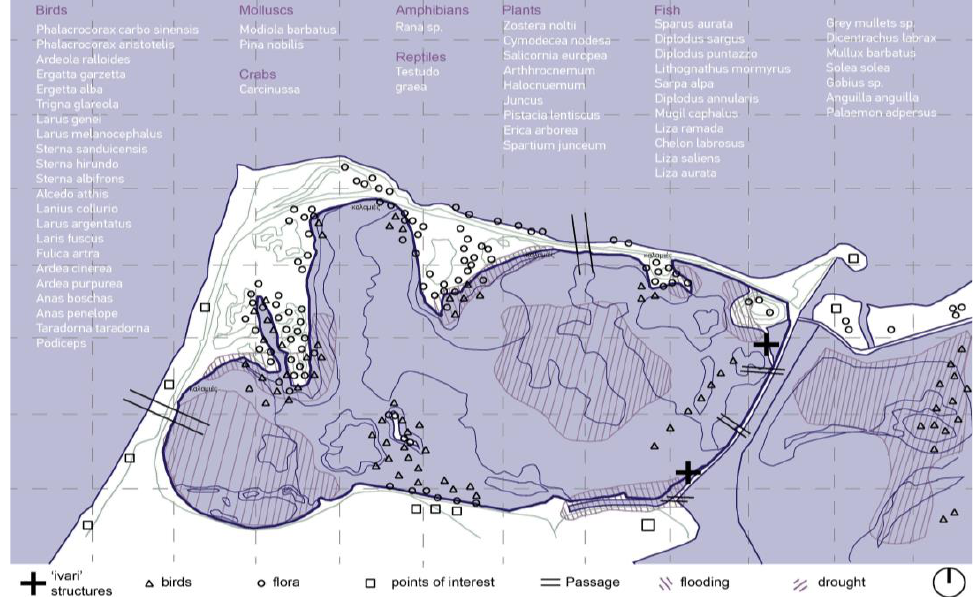
Figure 13. Eleni Kanellopoulou with Karolos Galanos (supervisor), 2022, Urban Safari 38.83, 20.70, Department of Architecture, University of Ioannina. Biodiversity map of the greater lagoon lake area showing species’ variety in relation to the sea tide during the year, which changes due to drought and rainfall periods. Reproduced with the permission of Kanellopoulou.